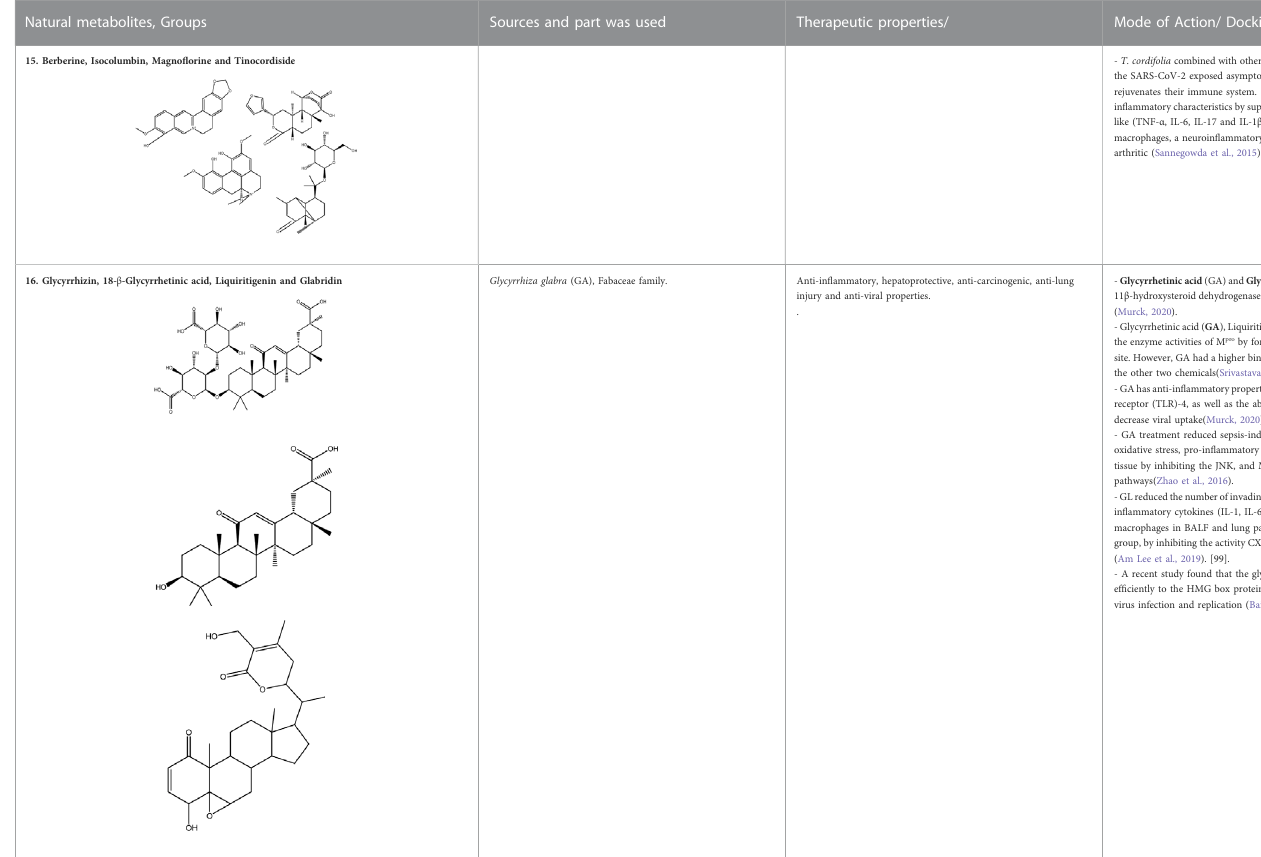
15.Berberine,Isocolumbin,Magno fl orineandTinocordiside - T.cordifolia combinedwithothermedicinalplantcalledayurvedicto